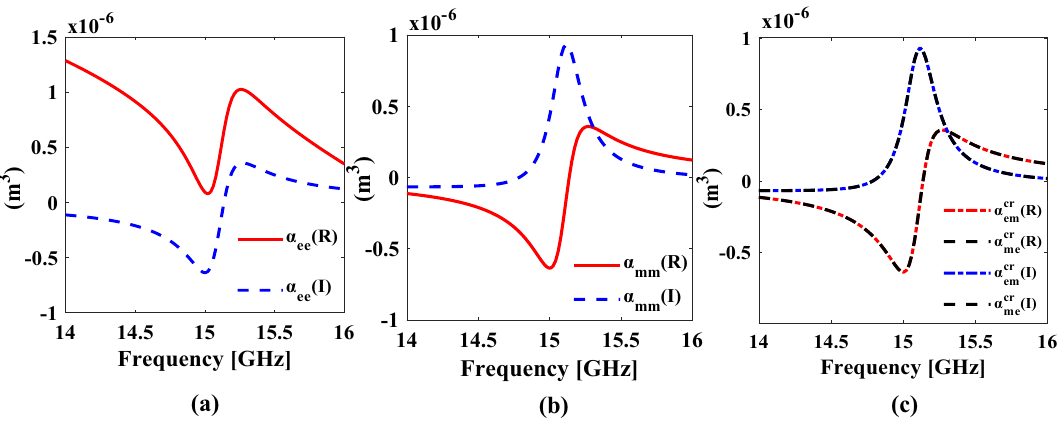
Figure 4. Individual Polarizability dyadics of designed omega bianisotropic ( a ) Electric polarizability ( b ) Magnetic polarizability ( c ) Electro-magneto and magneto-electric polarizability. *The figure is created using MATLAB ver. R2020A-URL: https:// www. mathw orks. com/ produ cts/ matlab.